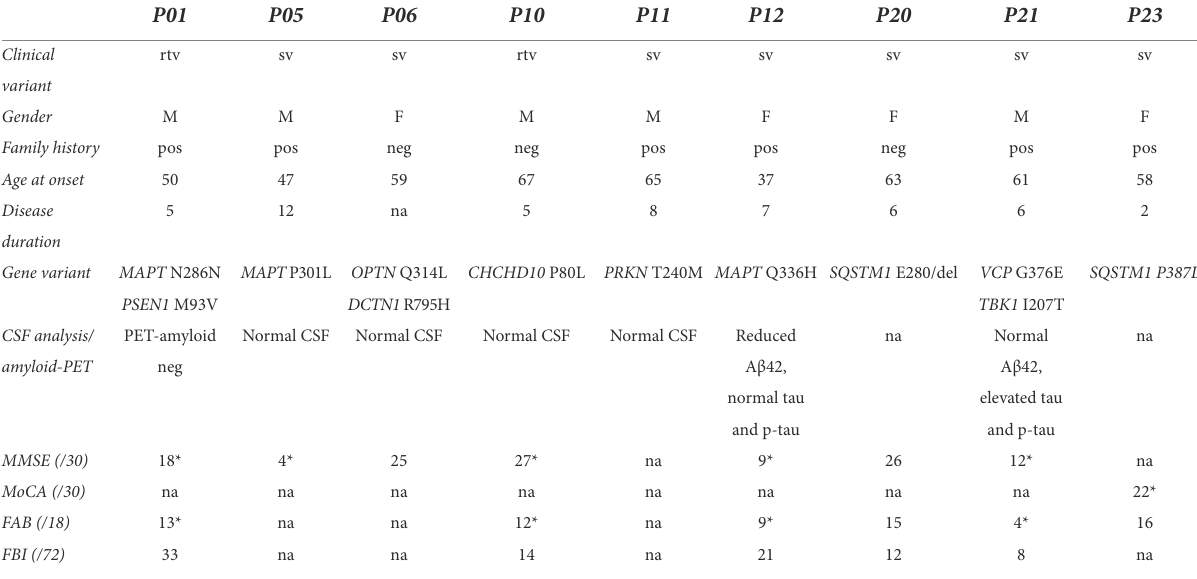
TABLE 3 Clinical and demographic characteristics of the 9 patients carrying the variants.